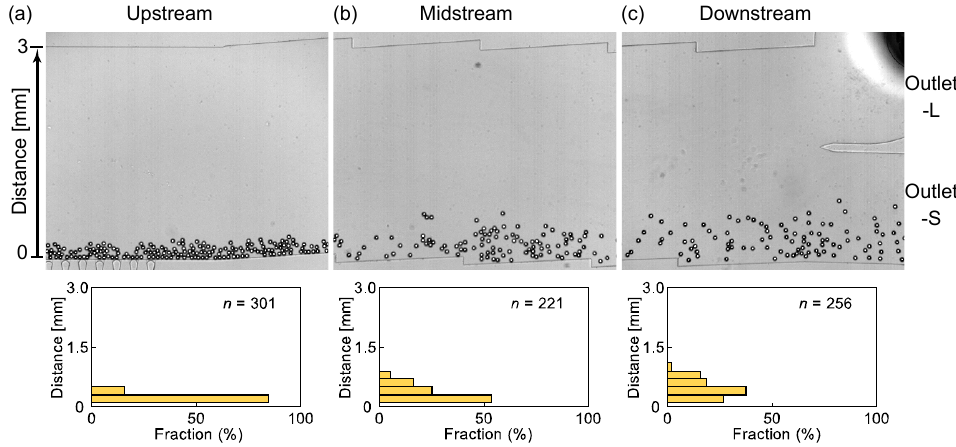
Figure 6. Spatial distribution of main droplets flowing in the no-pillar device. ( a – c ) Main droplets flowing through ( a ) the upstream region immediately after the nozzles, ( b ) midstream region, and ( c ) downstream region before the outlets. Flow rates were Q d = 0.1 mL/h and Q c = 10.0 mL/h.